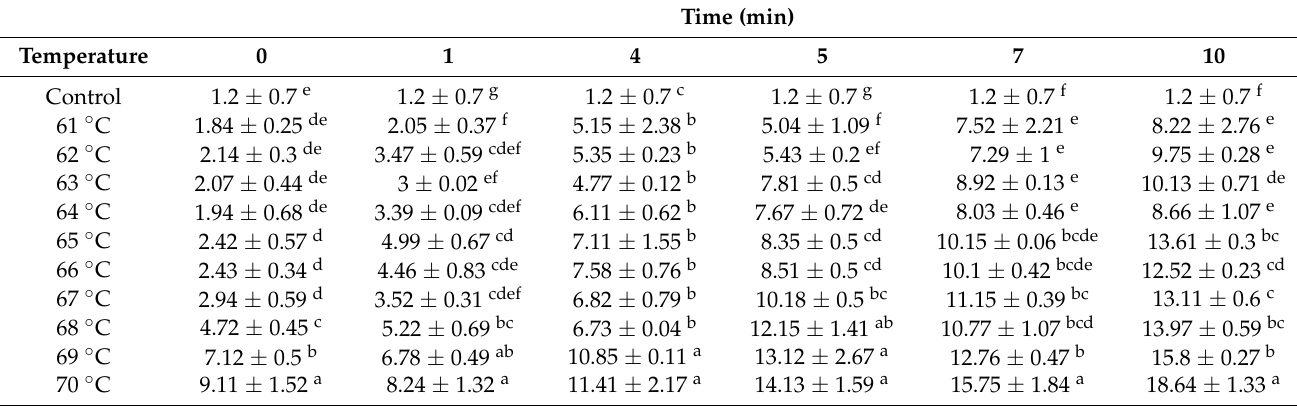
Table 1. Effect of heat treatment with varying time on LEY protein denaturation. Time